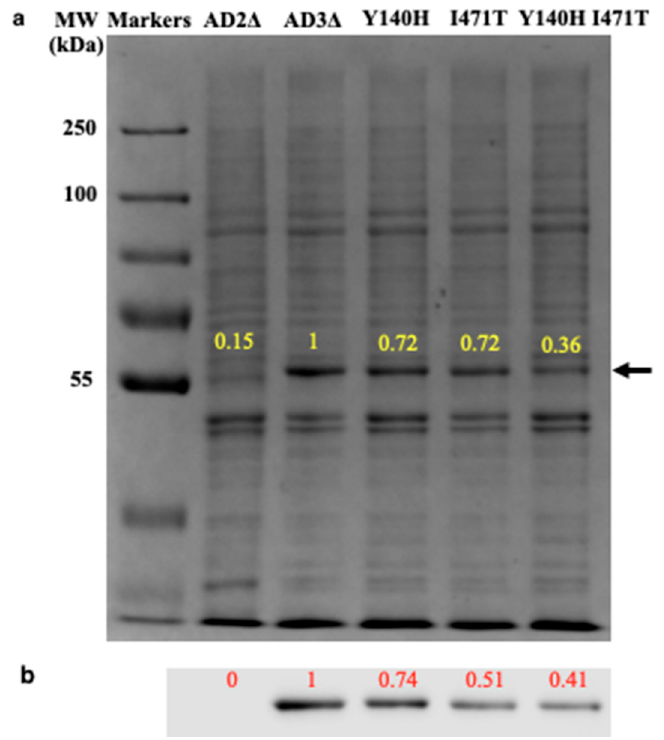
Figure 2. SDS-PAGE and western blot analysis of crude membrane fractions from control and test strains. ( a ) Coomassie blue R250-stained 8% acrylamide SDS-PAGE gel of samples of crude membranes (15 µg of protein) from strains overexpressing wild-type (AD3 Δ ) and mutant ScLDM6×His, with strain AD2 Δ used as a negative control. The positive control AD3 Δ ScLDM6×His band was assigned an arbitrary value of 1.00, and the intensity of the bands detected in test strains determined relative to this (yellow numbers). The black side arrow indicates the 62 kDa band containing ScLDM6×His; ( b ) Separated proteins electrotransferred onto nitrocellulose membranes were decorated with a mouse anti-6×His-peroxidase conjugated monoclonal antibody, and visualized using chemiluminescence. The band intensity for ScLDM6×His expression in strain AD3 Δ was assigned an arbitrary value of 1.00, and the intensity of the bands detected in test strains determined was relative to this (red numbers). An Odyssey Fc (LI-COR) imaging system was used to visualize the Coomassie blue stained gel and the Western blot.